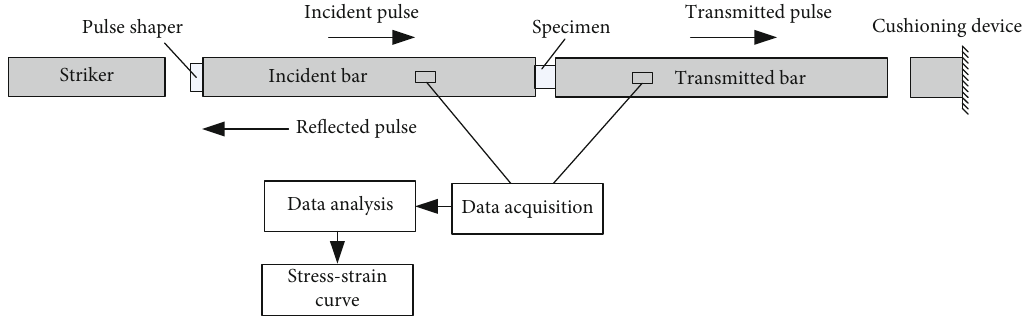
Figure 1: Structural constituents of SHPB